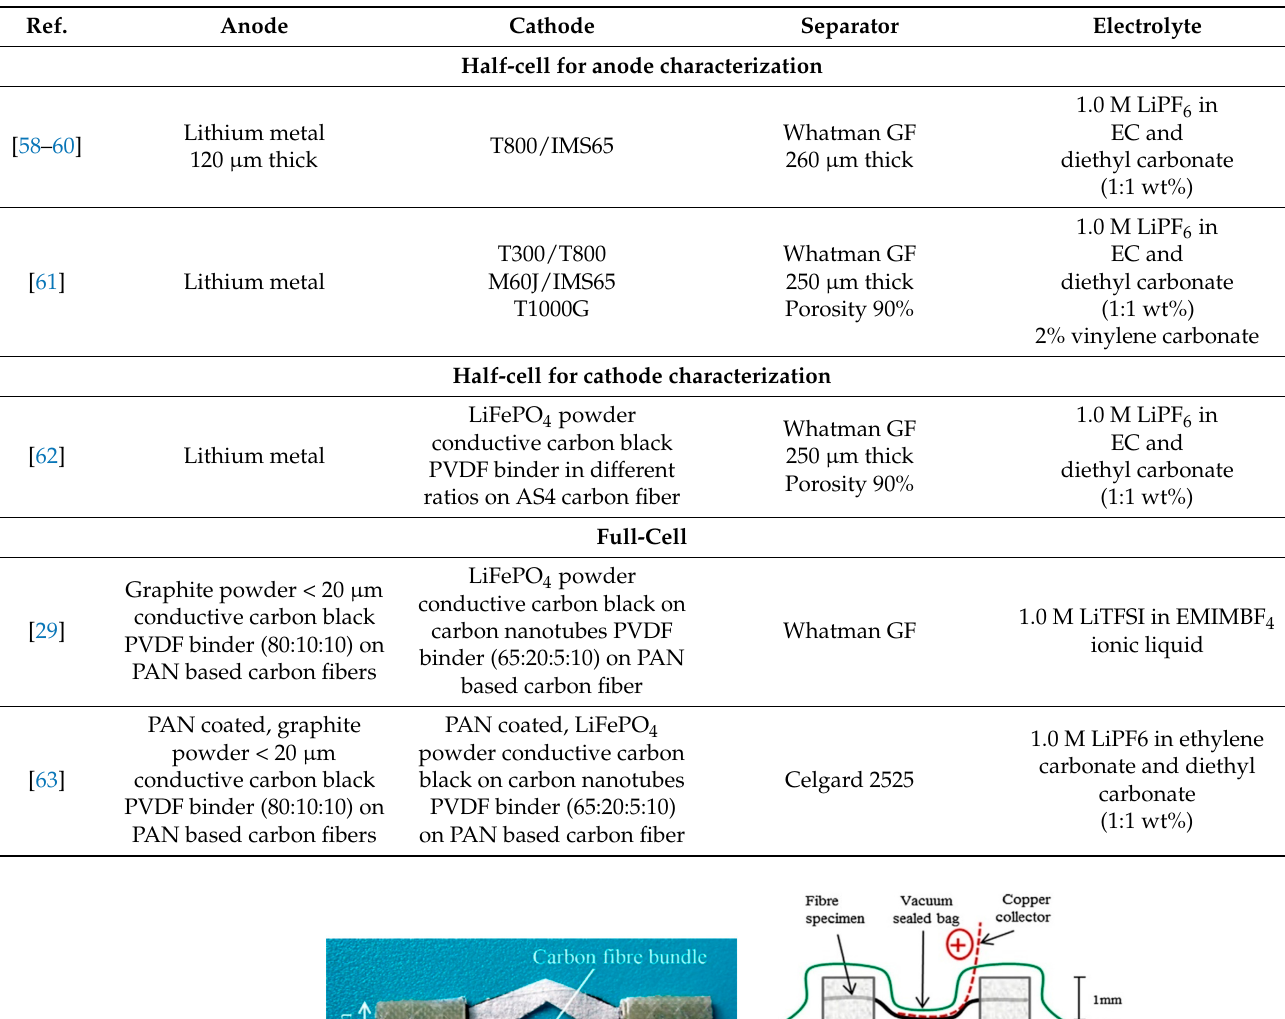
Table 2. Material list of structural batteries.